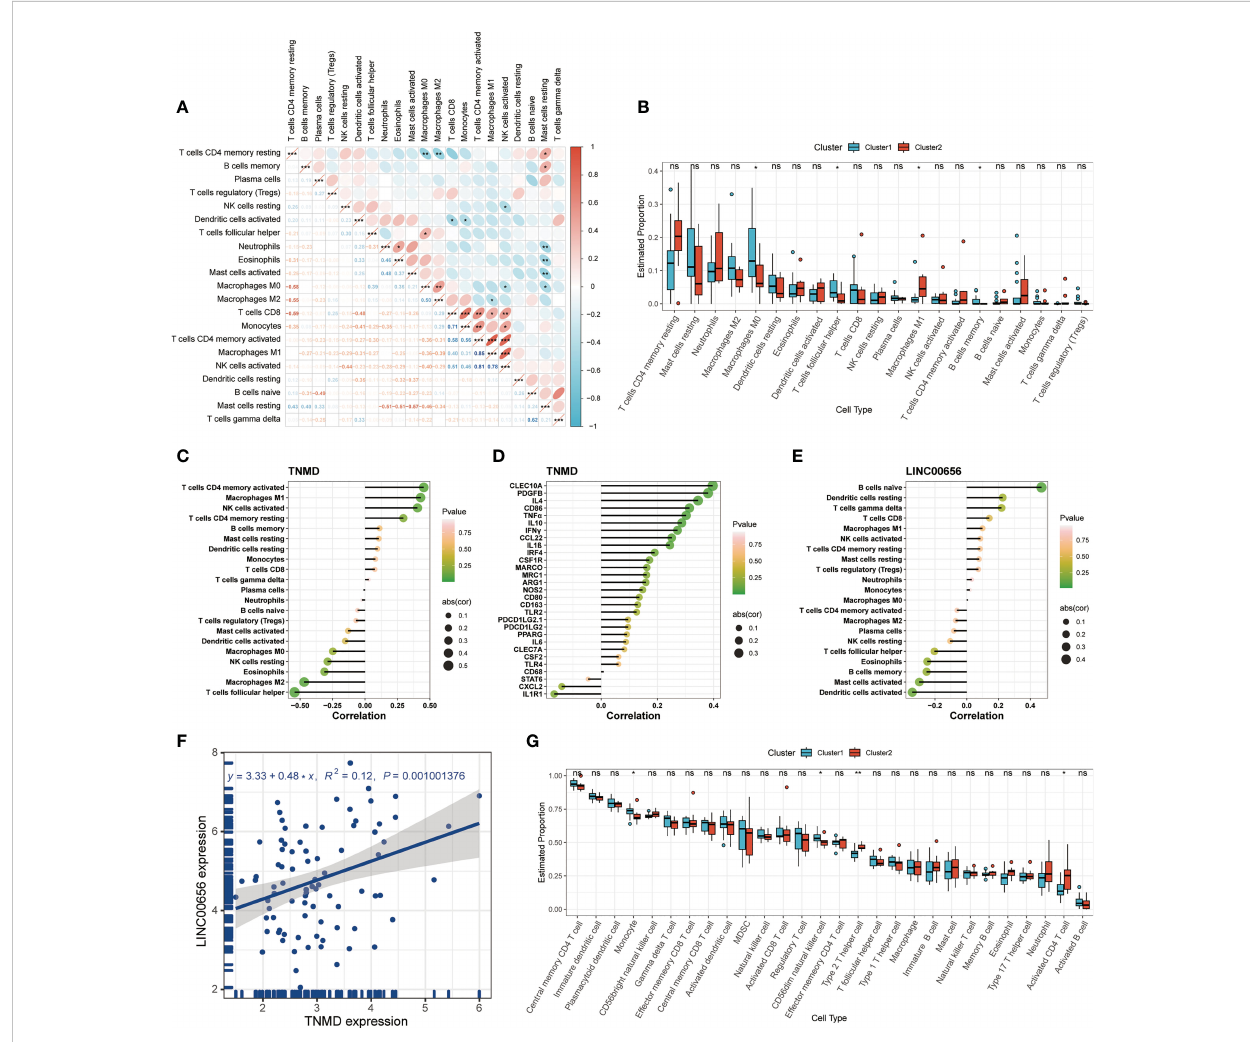
FIGURE 6 Immune cell in fi ltration characteristics in distinct anoikis patterns. (A) The heatmap of correlations among 22 immune cell types. The size of the colored ellipse indicating the strength of correlation. The red color indicating positive correlations, while the blue color indicating negative correlations. A darker color indicating a stronger correlation. (B) The boxplot showing the relative proportion of 22 immune cell types using the CIBERSORT algorithm. (C) The lollipop chart showing the correlation between the TNMD gene expression and 22 immune cell types. (D) The lollipop chart showing the correlation between the TNMD gene expression and several in fl ammation markers. (E) The lollipop chart showing the correlation between the LINC00656 expression and 22 immune cell types. (F) The correlation between the TNMD expression and LINC00656 expression. (G) The boxplot showing the relative abundance of each in fi ltrating immune cell type that differed between the two clusters using the ssGSEA algorithm. * P < 0.05; ** P < 0.01; *** P < 0.001; ns, no statistical signi fi